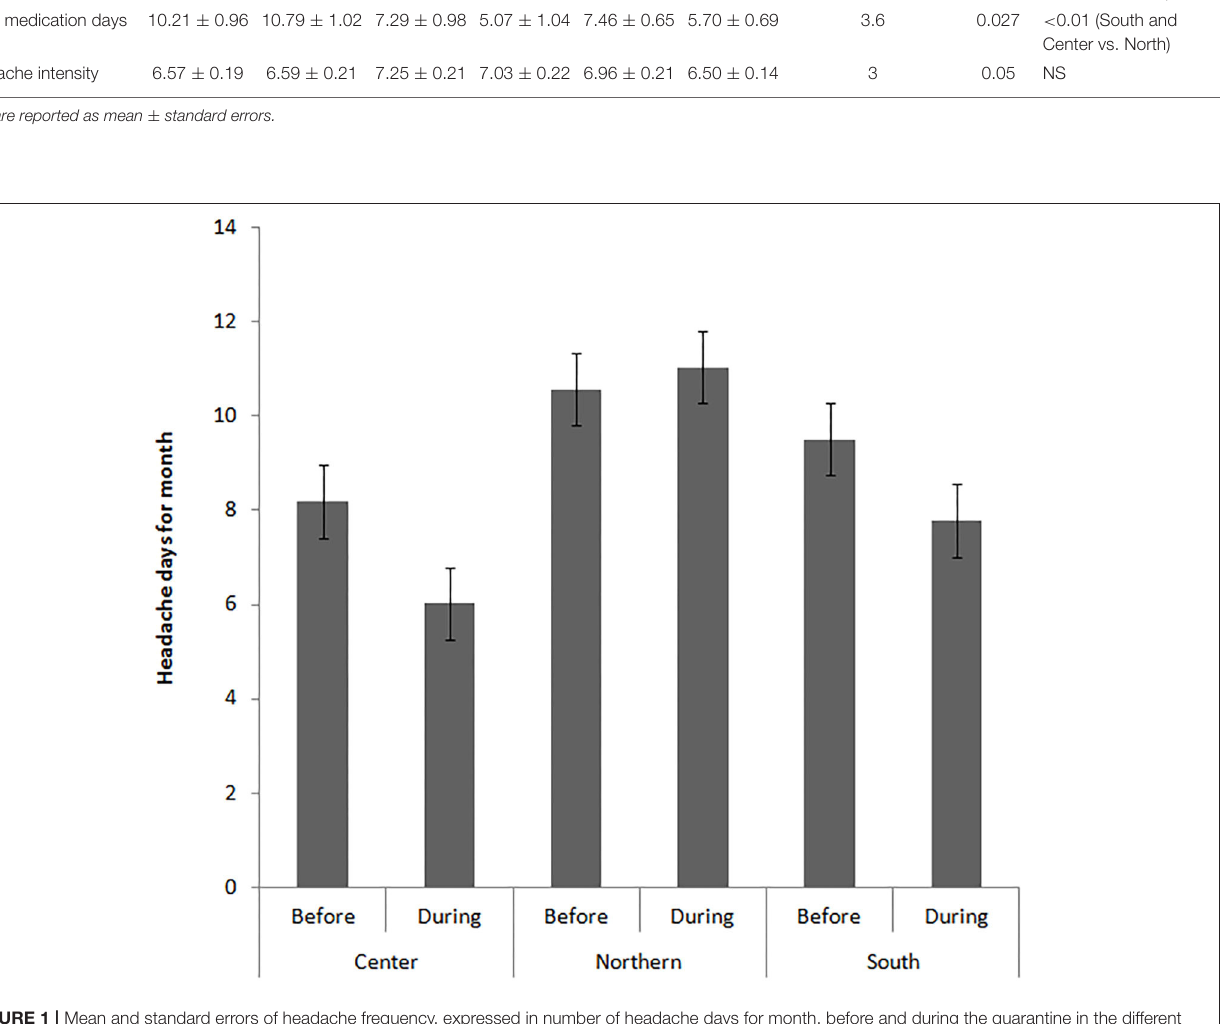
Frontiers in Neurology | www.frontiersin.org